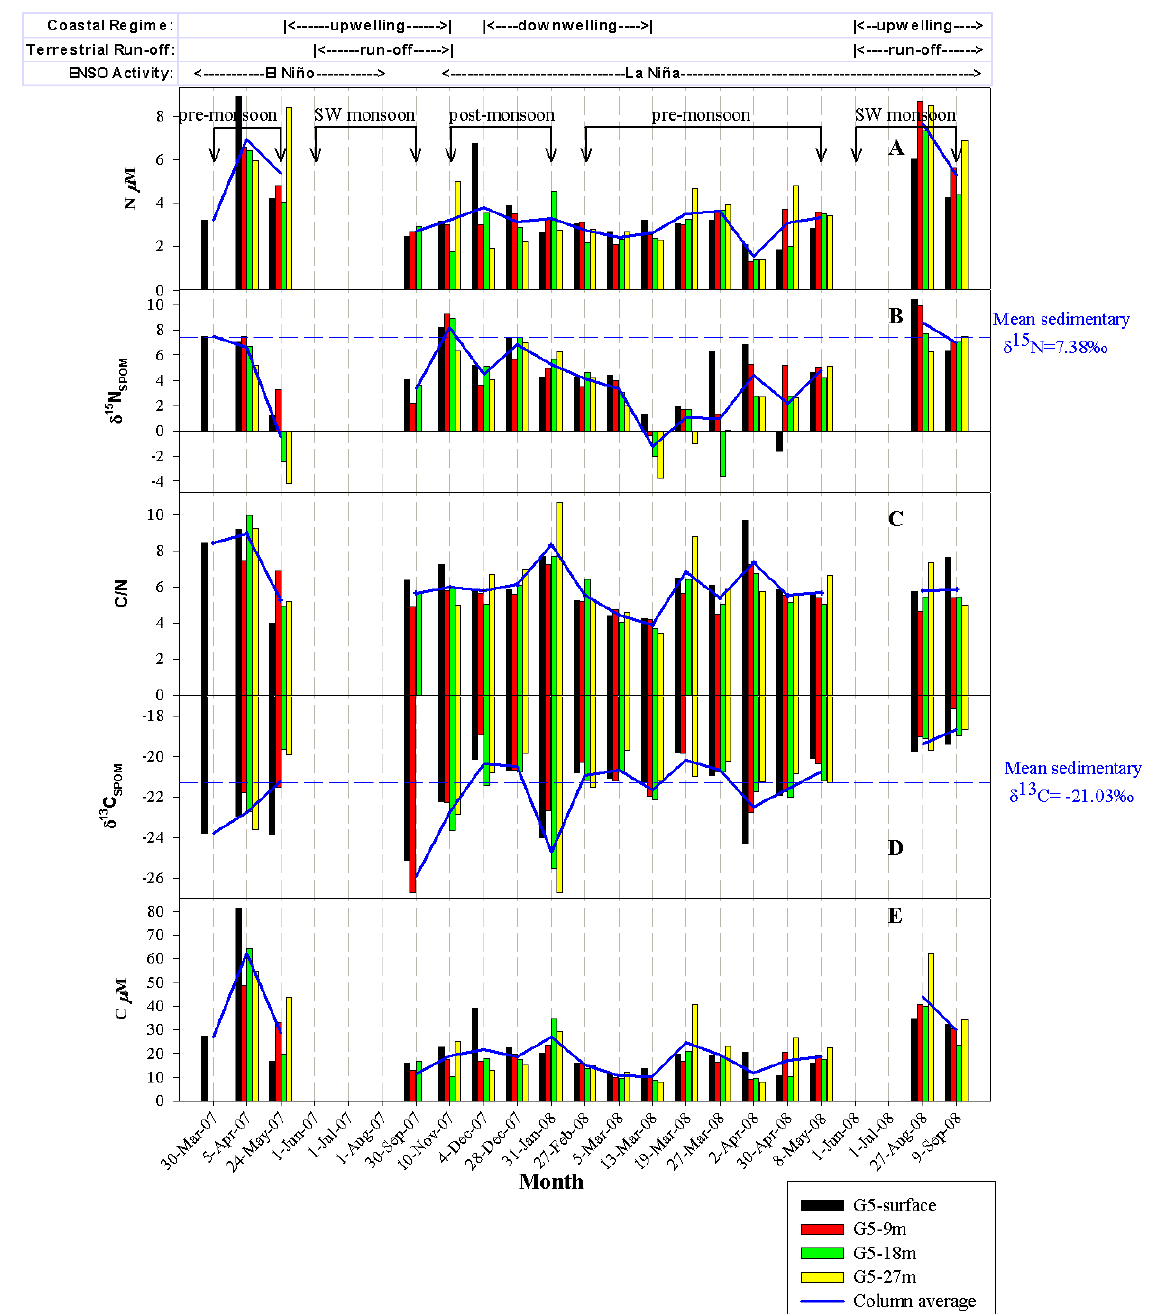
Fig. 3. Intra-annual variations of elemental nitrogen concentration (A) , δ 15 N (B), C/N (C) , δ 13 C (D) and carbon concentration (E) in SPOM at the CaTS site from March 2007 to September 2008. The three seasons (pre-monsoon, SW monsoon and post-monsoon) are marked in the figure. The bold blue line represents column-averaged values (0m, 9m, 18m and 27m) for each parameter.